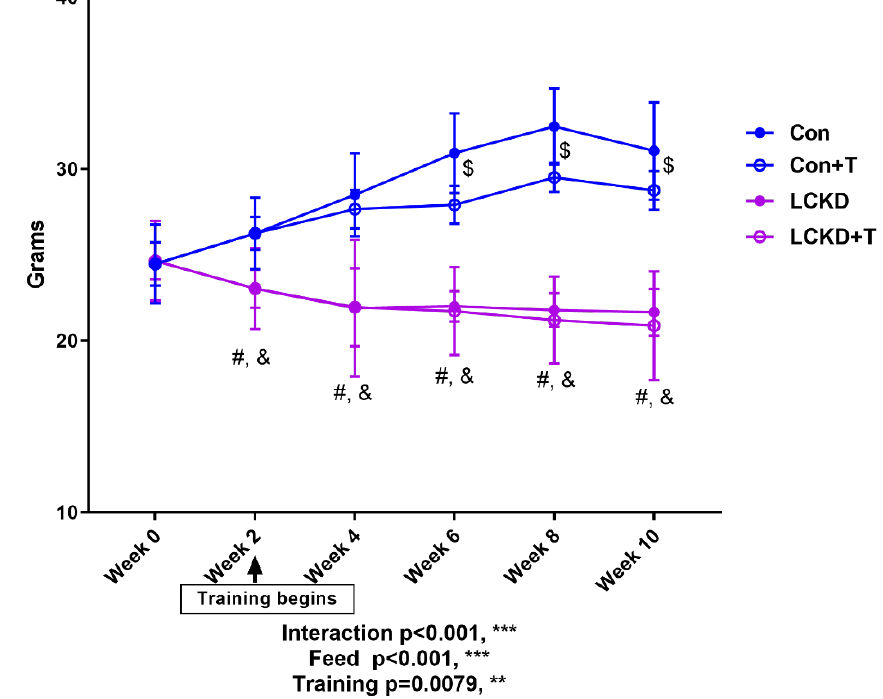
Figure 1. Weight change throughout the experiment. Con, Con + T, LCKD, and LCKD + T stand for chow diet, chow diet plus training, low-carbohydrate ketogenic diet, and low-carbohydrate ketogenic diet plus training, respectively. Feed indicates a main effect of diet, training indicates a main effect of treadmill exercise, and interaction indicates the interactive effect between feed and training. Interaction refers to the interactive effect between diet and training. ** p < 0.01 and *** p < 0.001. #, significant difference between Con and LCKD; &, significant difference between Con + T and LCKD + T; $, significant difference between Con and Con + T. A two-way analysis of variance (ANOVA) was performed to determine the effects of diet, training, and interaction. When ANOVA indicated a significant effect, a Tukey’s post hoc test was performed to determine the significance of differences between means. Statistical significance was set at p < 0.05. Data are presented as the mean ± standard deviation (SD). n = 8 for each